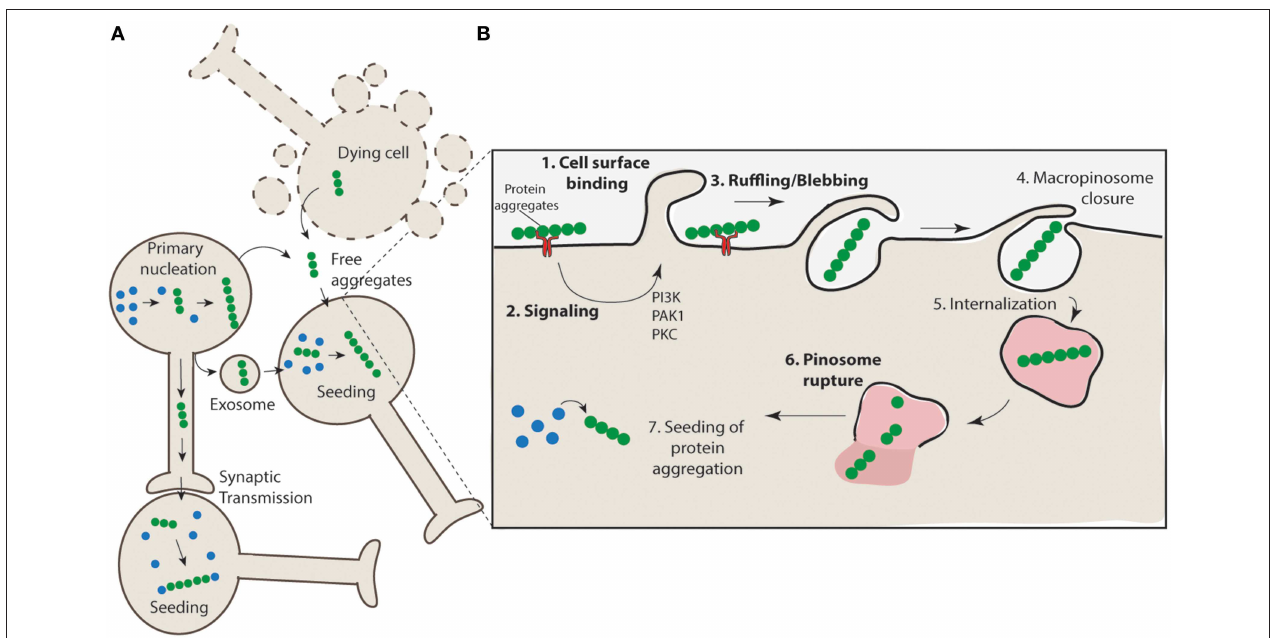
FIGURE 2 | Propagation of aggregation and a proposed mechanism for aggregate uptake via macropinocytosis. (A) Protein aggregates form in neurons (primary nucleation) and have the potential to further nucleate the aggregation of other proteins. These protein aggregates can transfer directly from cell-to-cell through synaptic transfer, or be actively released via secretion mechanisms (e.g., exosomes) or in their naked form, either actively released from live cells or non-specifically released from dying cells, to neighboring interconnecting neurons. The uptake of such aggregates nucleates aggregation in naïve cells. (B) Aggregates may interact with cell surface receptors (such as HSG) (1) and promote the clustering and activation of signaling receptors such as receptor tyrosine kinases. This may result in the activation of signaling pathways such as those regulated by PAK1 and PKC (2) and subsequent mobilization of actin and formation of ruffles/blebs (3). Upon macropinosome closure (4) the structure is internalized (5). Given the unstructured nature of the macropinosomes it is likely that rigid aggregate structures may cause rupture (6) and allow access of the aggregates to the cytosol where nucleation of aggregation can proceed